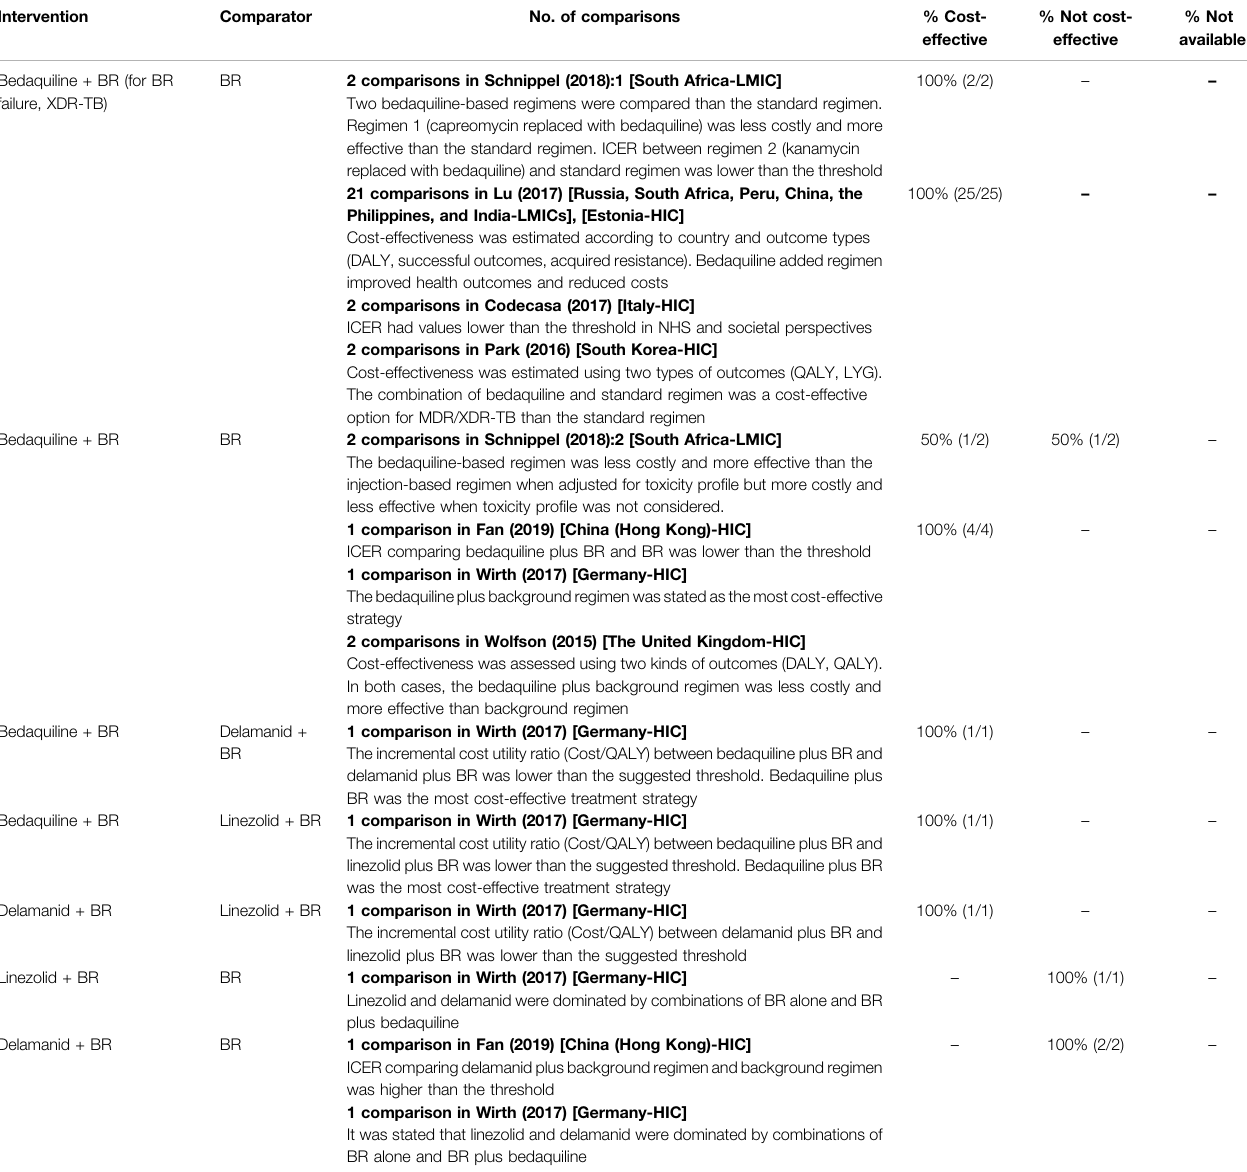
TABLE 3 | Cost-effectiveness of interventions in studies comparing regimens for MDR-TB patients. Intervention Comparator No. of